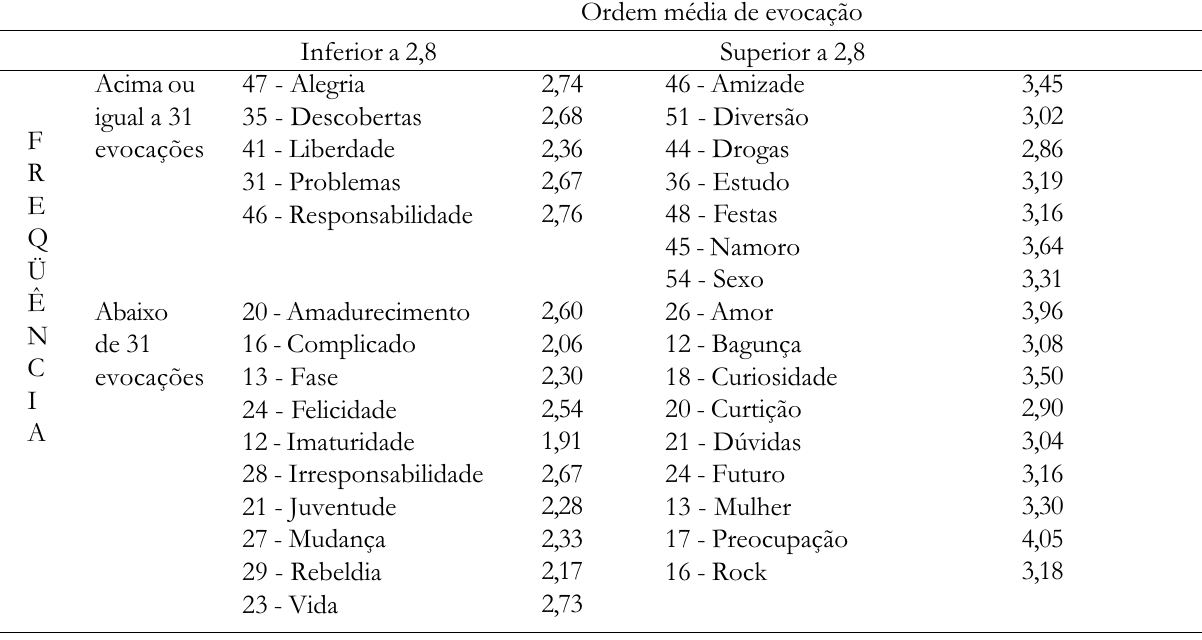
Elementos da Representa(cid:231)ªo dos Sujeitos sobre a AdolescŒncia, em Fun(cid:231)ªo da Freq(cid:252)Œncia e Ordem MØdia de Evoca(cid:231)ªo (n=360) Ordem mØdia de